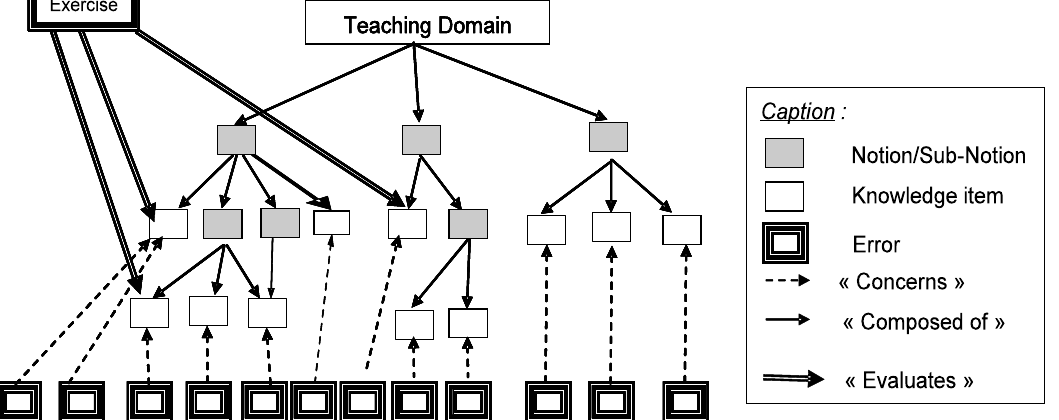
Fig. 3. Overview of Teaching Domain Ontology